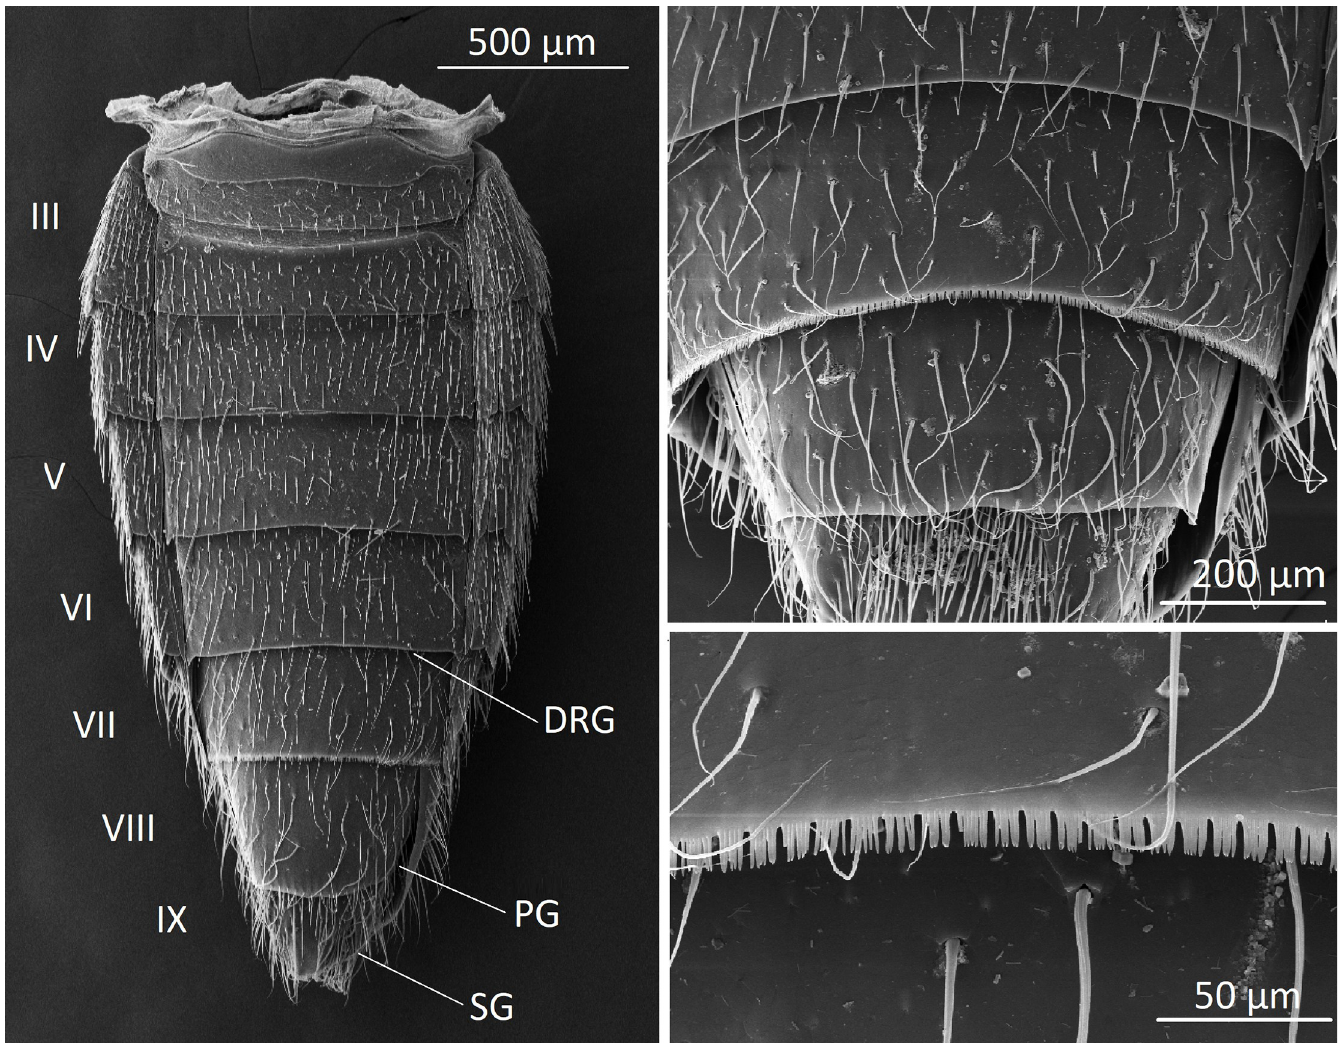
Fig 1. Scanning electron microscopic images of the abdomen of Dinarda dentata . a) Whole abdomen of the beetle showing the externally visible 8 full ring (tergum plus sternum) segments, beginning with segment III to IX. The repellent-defense tergal gland opens between segments VI and VII tergites. The paired pleural gland opens dorsa-laterally between the segment VIII and IX. The paired sternal gland opens at the posterior–lateral sides of segment IX. b) The posterior rim of tergite VII features a serrate structure not present in the other tergites or sternites. c) Close-up of the serrate structure along the posterior rim of tergite VII.